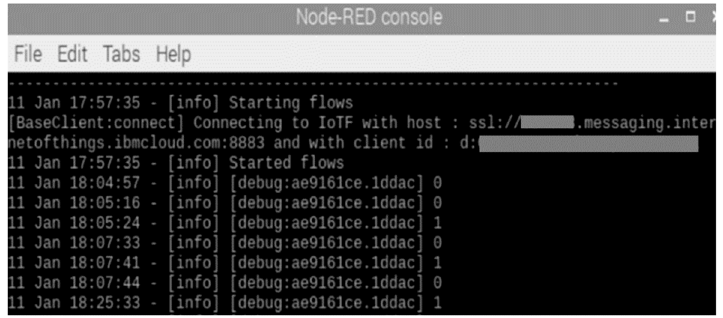
Figure 17. Success message of the LED request in Node-RED.